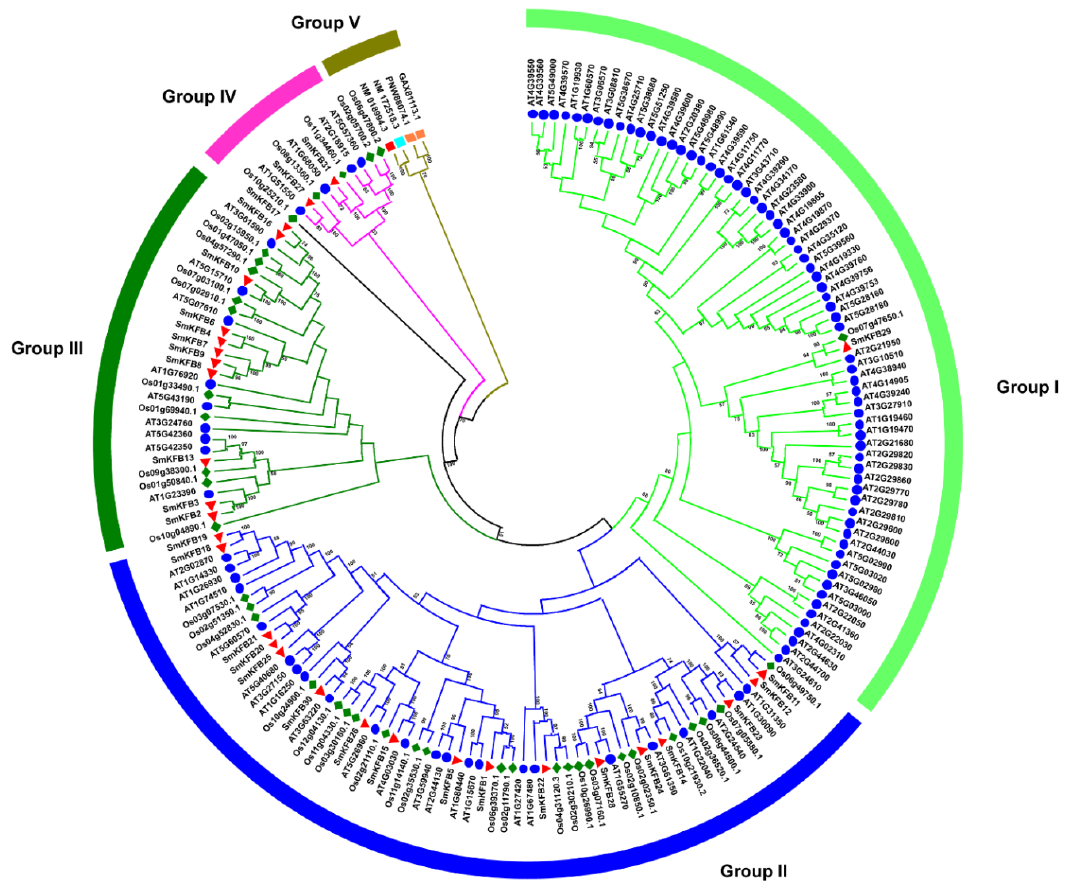
Figure 1. Phylogenetic analysis of Kelch repeat F-box (KFB) proteins from S. miltiorrhiza and other organisms. The tree was constructed from amino sequences using MEGA 6.0 via the neighbor-joining (NJ) method with 1000 bootstrap replicated. The blue circles, red triangles, dark green diamonds, red squares, orange pale squares, and blue squares represent KFBs from A. thaliana , S. miltiorrhiza , O. sativa , Homo sapiens , M. musculus , and C. reinhardtii , respectively. Clades with different colors represent diverse groups.